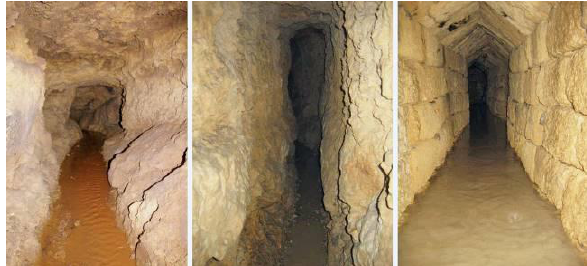
Figure 1. “Corso Gesuitico Alto”. From the left, morphology of level 1, level 2 and level 3 sections of tunnels.